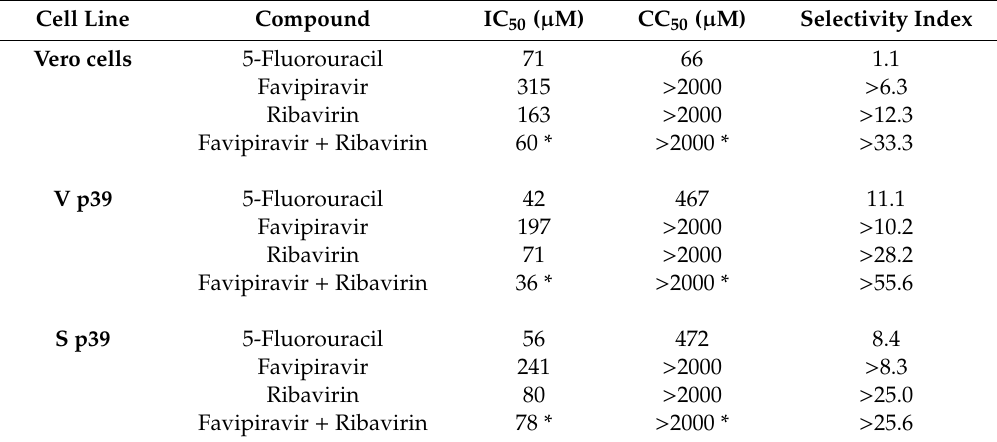
Table 2. Antiviral activity of nucleoside analogues against USUV in lytically and persistently-infected